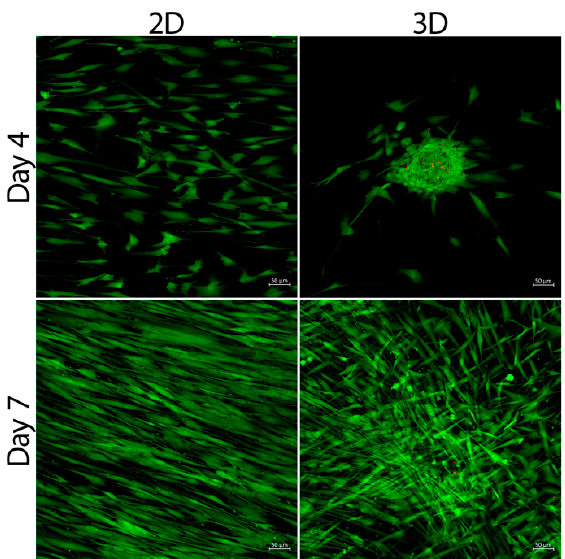
Figure 2. Live and dead staining for 3D SCAP spheres and 2D SCAPs at different time points.